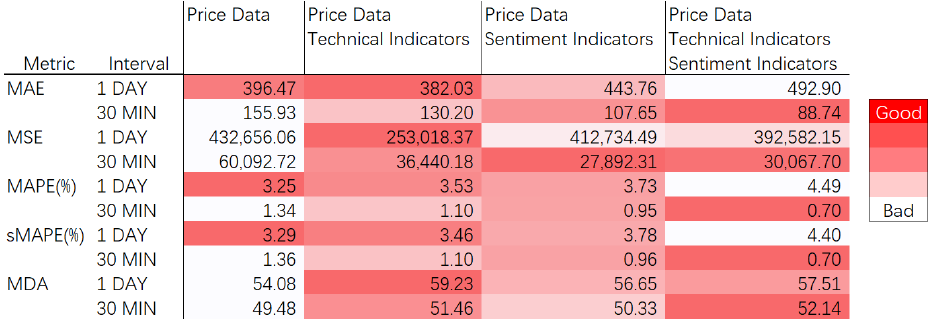
Figure 11. Stacking ensemble model prediction results of the data